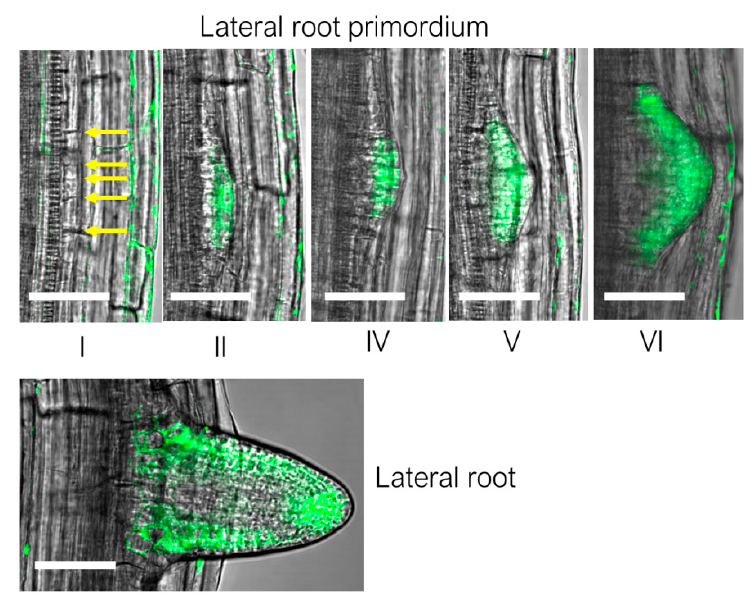
Figure 2. Expression patterns of At3g08030 during lateral root development. The Arabidopsis pAt3g08030::ER-GFP- transgenic plants were obtained as described in Salazar-Iribe et al. [19]. Roman numerals indicate the developmental stages of the lateral root initiation process. The images are all section images. n = 8–10 roots for each developmental stage. Scale bars = 20 µm. 130 Table 1. Expression profiles of the DUF642 genes detected in distinct tissues/organs and species. 131 DUF642 genes are grouped by clades as reported by Vázquez-Lobo et al. (2012) [9] and using the locus 132 tag of Arabidopsis as a reference for gene grouping. 133